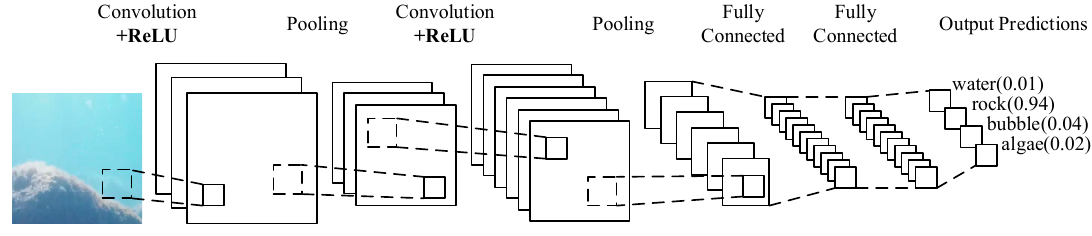
Figure 1. A CNN model for image recognition.